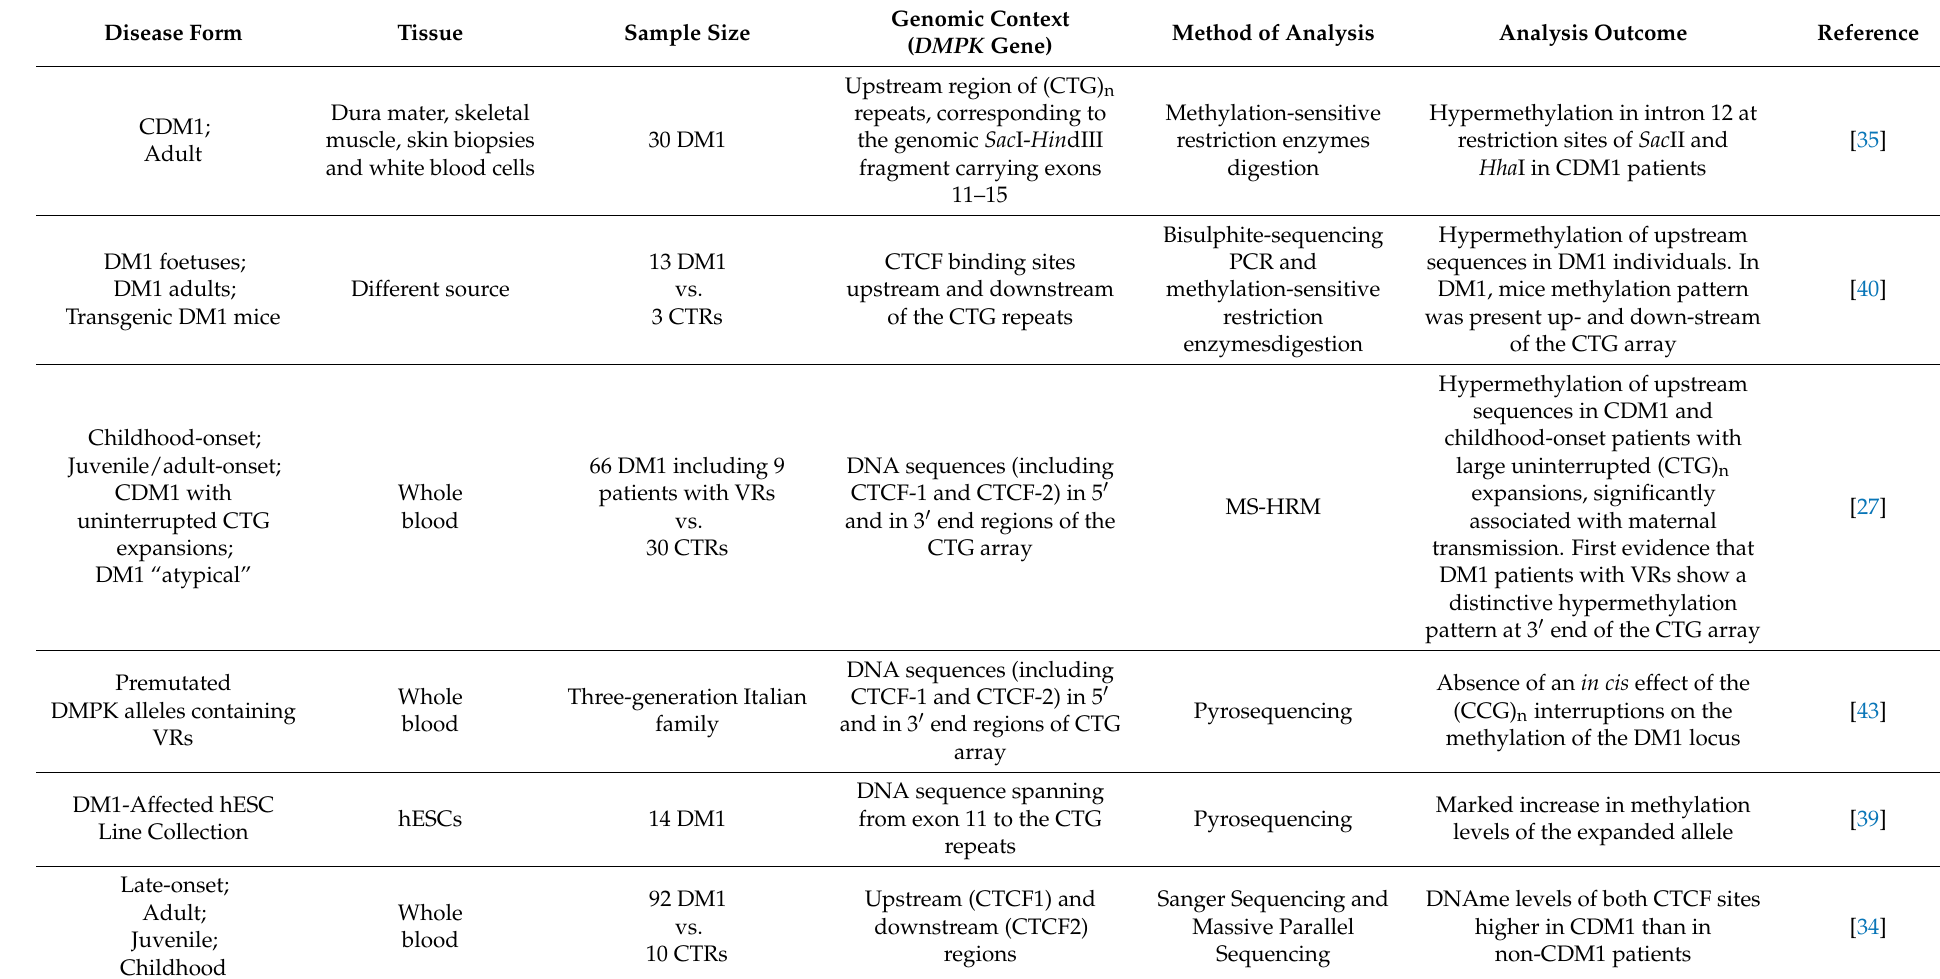
Table 1. DNAme studies in DM1, DM2 and control (CTR)